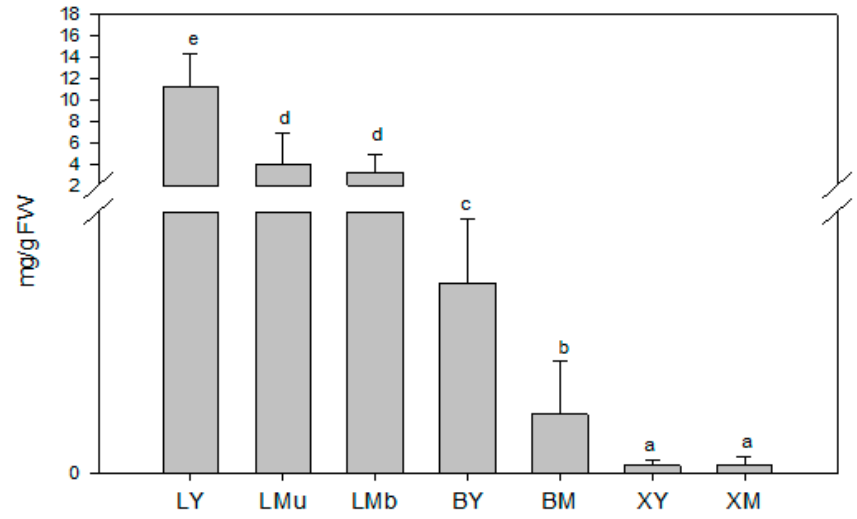
Figure 2. Total contents of volatile terpenoids (mg/g fresh weight (FW)) in young and mature tissues and different tissue sources from Rosmarinus officinalis L. Data are means of 9 replicates + SE (standard error). Different letters indicate significant differences (by the Mann–Whitney U-test, p < 0.05). L, leaf; B, cortex; X, xylem tissue; Y, young tissue; M, mature tissue. Samples collected from the upper part (u) and at the base (b) of the branch are indicated respectively, as “u” and “b”.